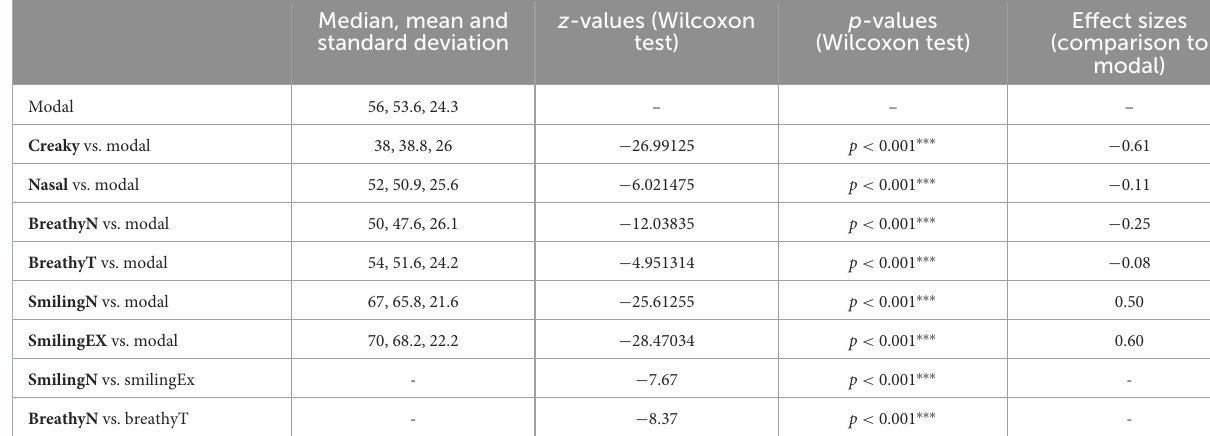
TABLE 2 Mean, median and standard deviations for each vocal quality (the bold-printed vocal quality values of the first column are reported) and results of the statistical Wilcoxon signed-rank pairwise significance test (z-values: third column; p -values: fourth column) comparing the two vocal qualities stated in column one, calculated over all participant